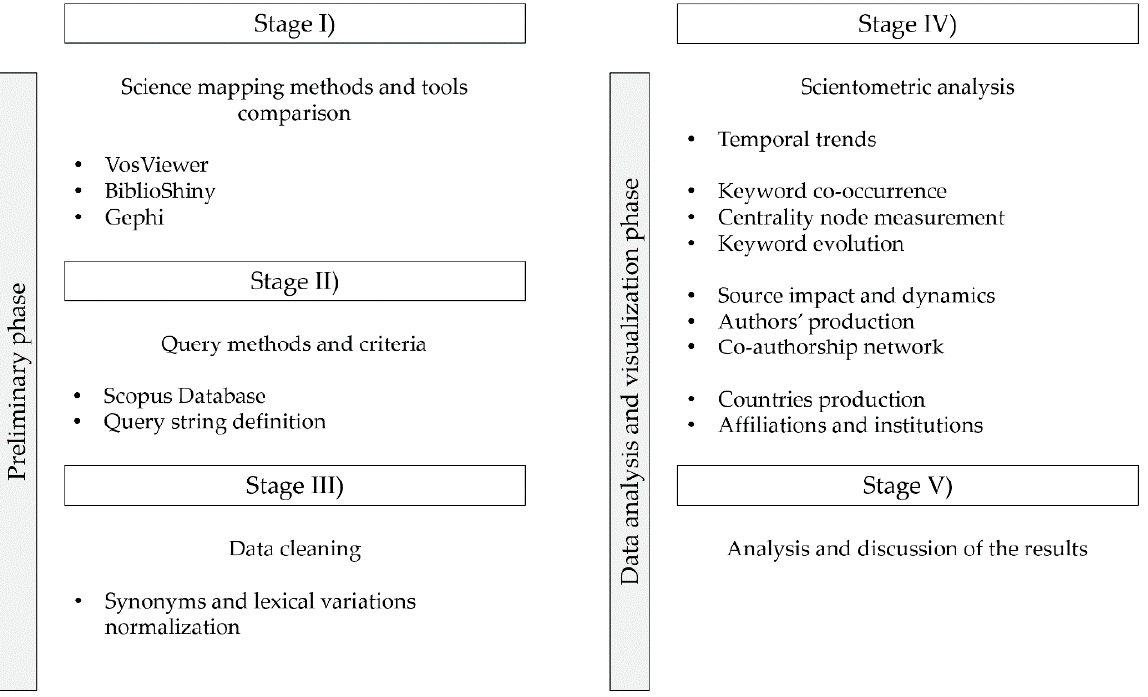
Figure 1. Methodology steps schema.